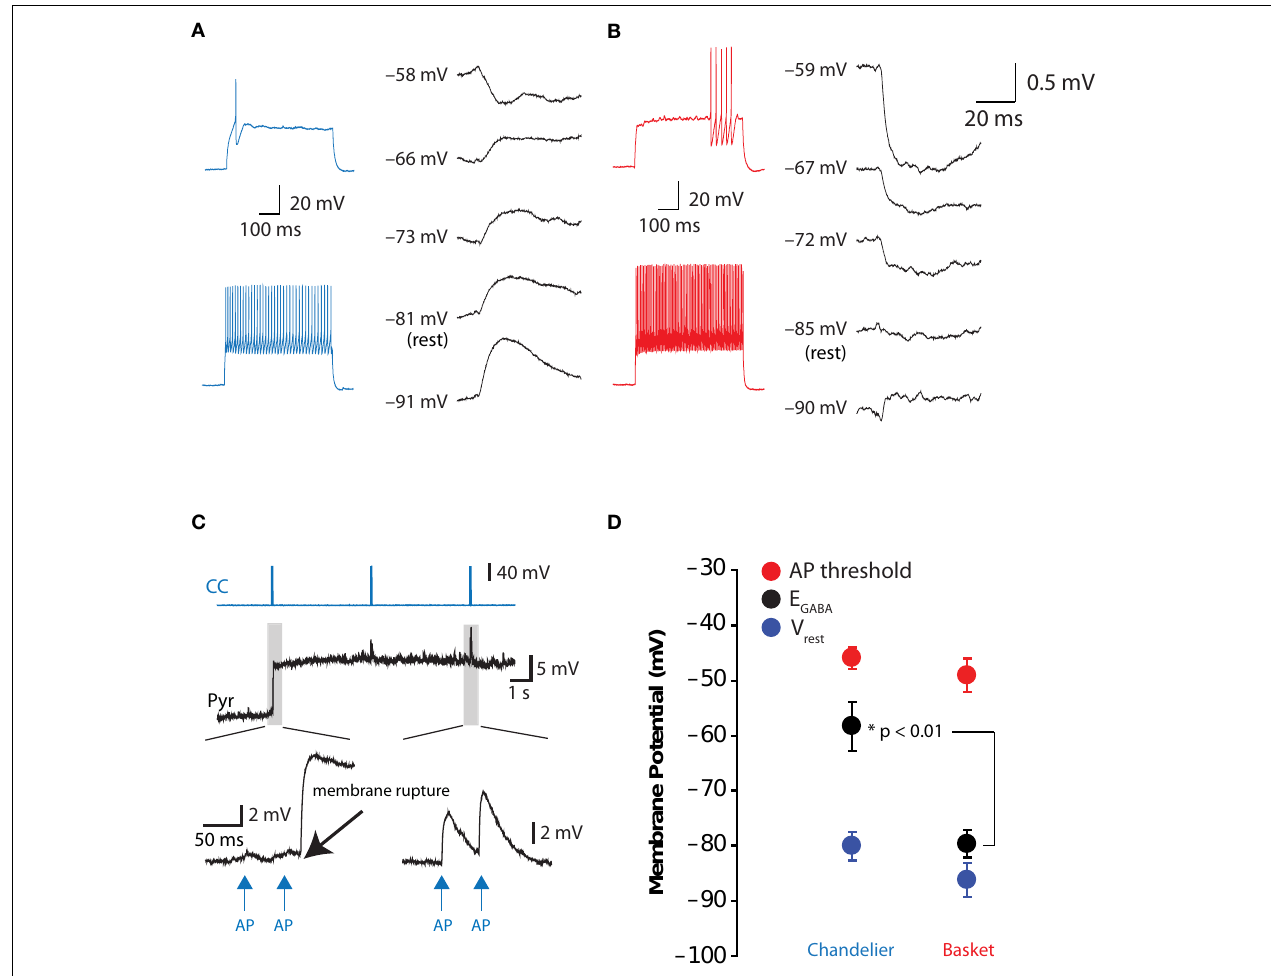
FIGURE 3 | Effect of chandelier neurons on postsynaptic pyramidal cells. (A) Response of pyramidal cell to single chandelier cell action potential. Chandelier cell was identifi ed based on its threshold fi ring properties ( left ) (B) As for (A) , for presynaptic basket cell. (C) Illustration of the membrane potential jump and enlargement or GABAergic PSPs following transition from perforated-patch to whole-cell confi guration. (D) Summary data of all recordings. **: p < 0.01, ***: p <